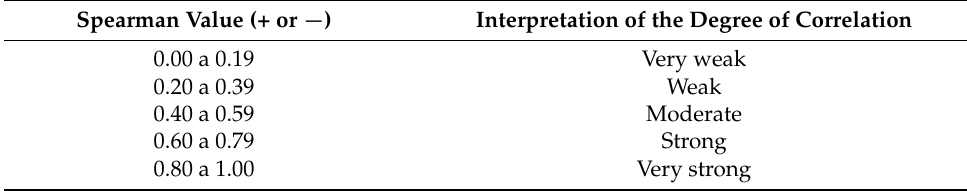
Table 1. Interpretation of Spearman correlation